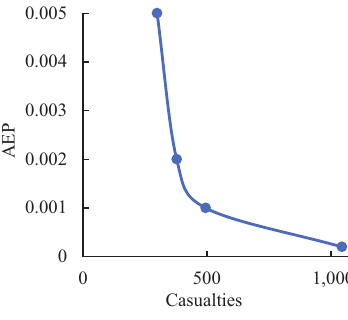
Figure 8. Flood casualty – AEP